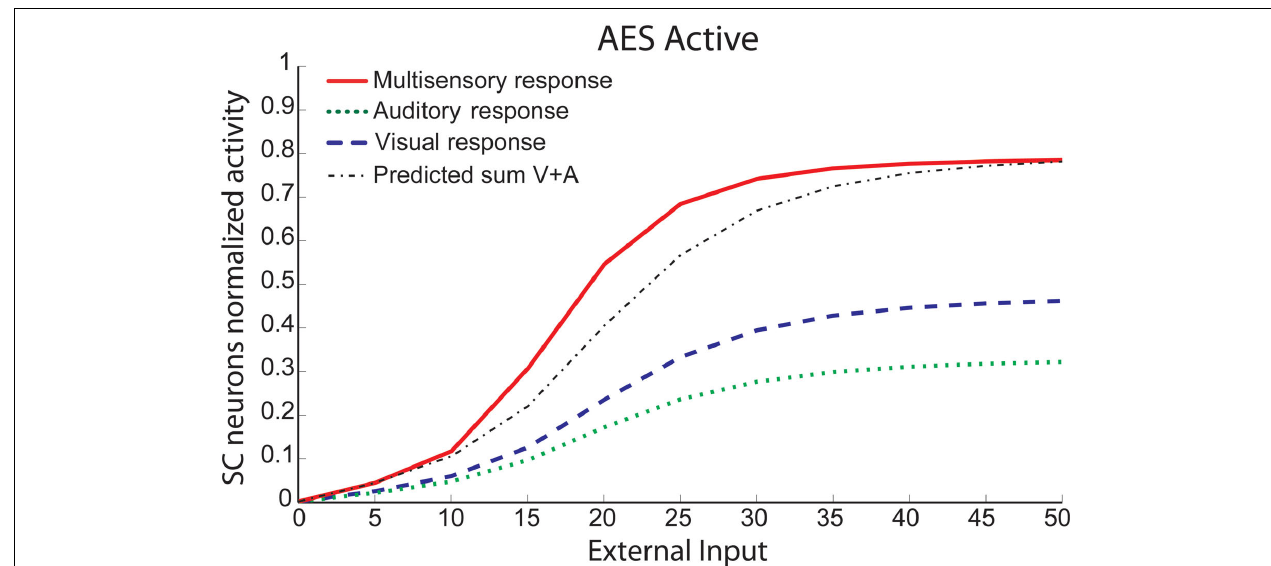
(dotted line), visual (dashed line) and multisensory (solid line) inputs at various intensities. The stimuli were presented in the center of the RF of the observed SC neuron. Note that the model shows a response to a cross-modal stimulation greater than the predicted sum of the two modality-specifi c